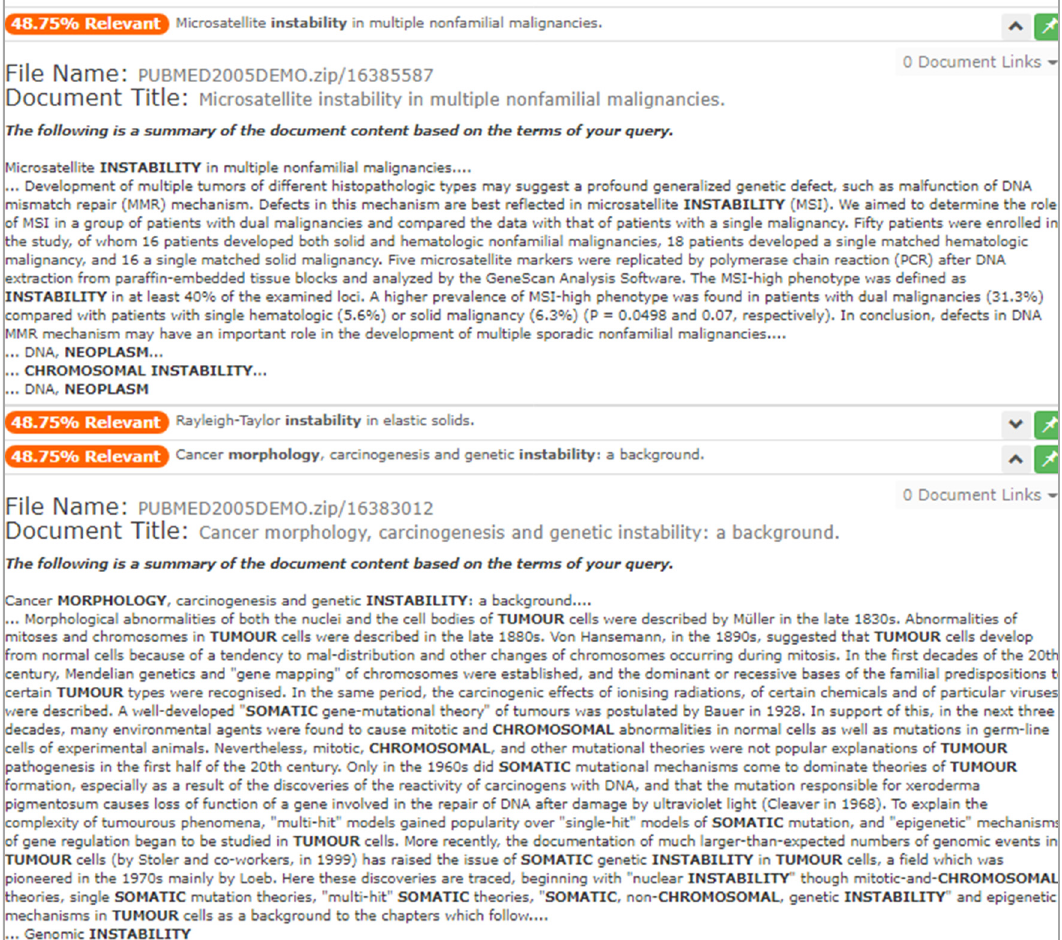
Figure 13. ONTSI after the user has selected new document entries for deeper inspection.